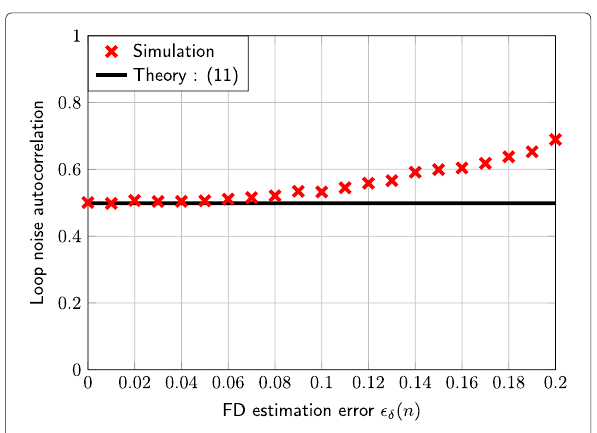
Fig. 5 Theoretical and simulated zero-delay autocorrelation of loop noise versus estimation error of the FD estimator